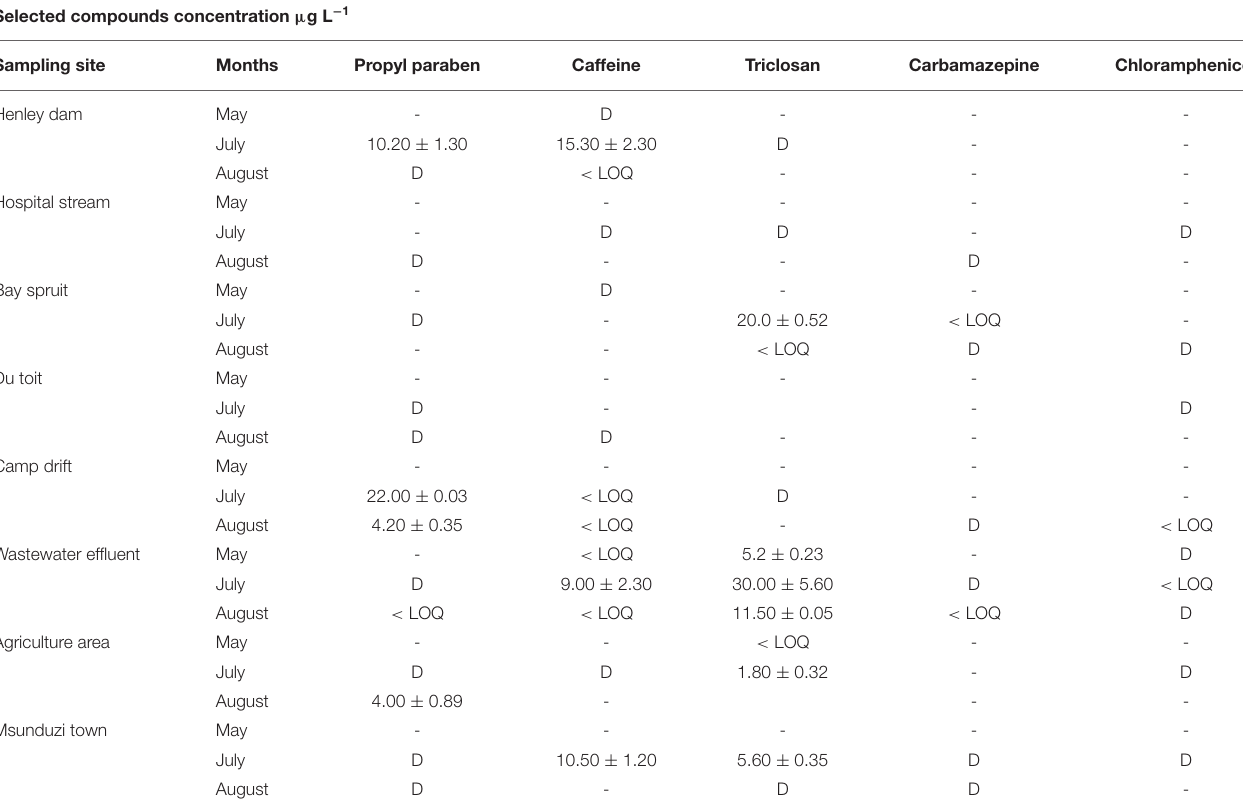
TABLE 6 | Concentration ( µ g L − 1 ) of personal care products and pharmaceuticals in fresh water and wastewater along the Msunduzi river. Selected compounds concentration µ g L −